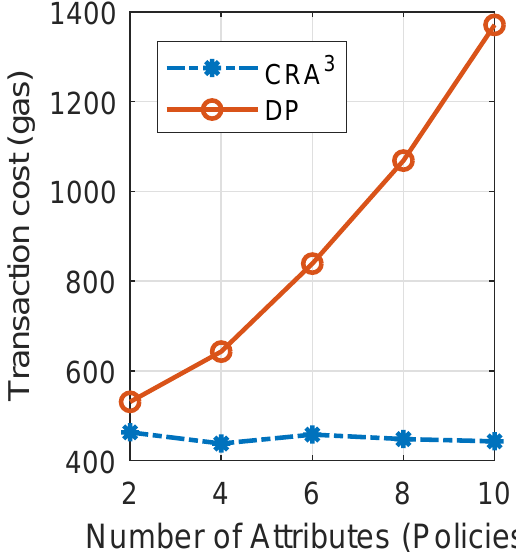
Figure 6. Transaction fee of CRA 3 and DP [12] for